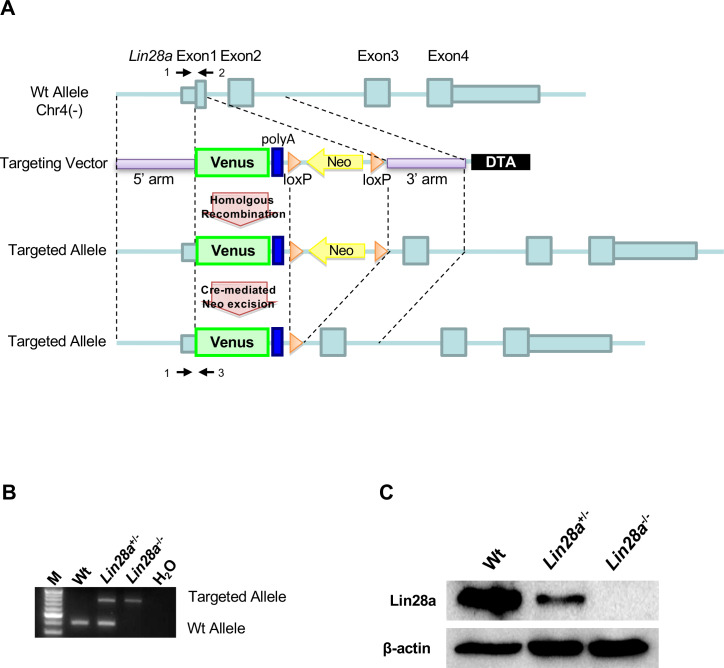
Generation of Lin28a–/– mice.(A) Schematic diagram of the Lin28a gene-targeting construct. The small light-blue box indicates the 5’ and 3’ untranslated regions (UTRs), and the large light-blue box indicates the coding region. Arrows (1–3) show the genomic PCR primers used for genotyping. 5’ and 3’ arms, 5’ and 3’ homology arms; Neo, PGK promoter and neomycin-resistance gene; DTA, diphtheria toxin A chain. (B) Genotyping via PCR of Lin28a mutants. The Wt allele produced PCR products of about 400 bp, whereas the targeted allele yielded products of about 750 bp. (C) Western blot analysis of Lin28a in E9.5 whole embryos. β-actin is shown as a loading control.